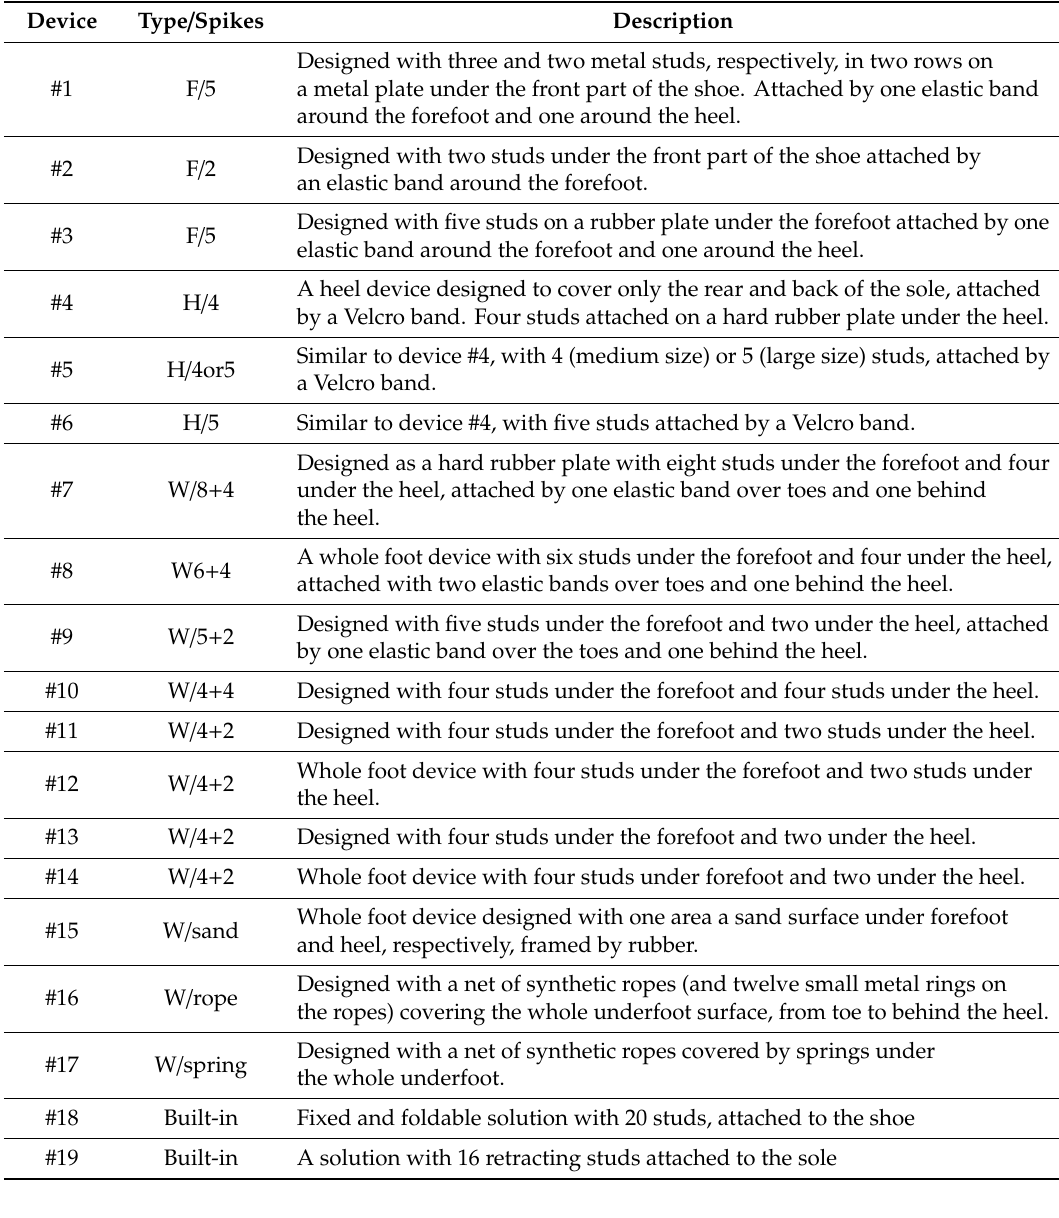
Table 1. Description of the devices from the four design groups: Forefoot device (F), heel device (H), whole foot device (W), and shoes with built-in studs.